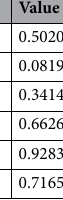
Table 12. Cohen’s kappa coefficient, recall and precision results for the multi-lameness classifiers.